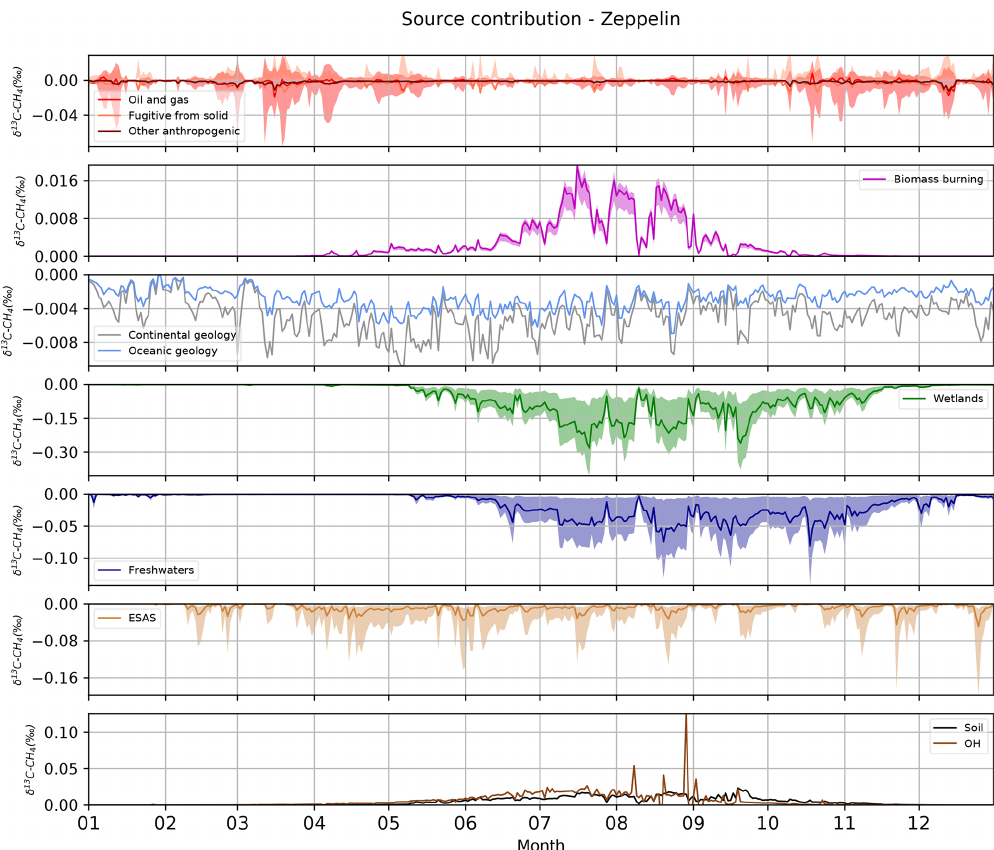
Figure 4. Time series of δ 13 C CH4 contributions of each source (in ‰), simulated by CHIMERE, in Zeppelin in 2012. The coloured shades represent the range of δ 13 C CH4 values when varying isotopic signatures (see Table 2). (Note the different